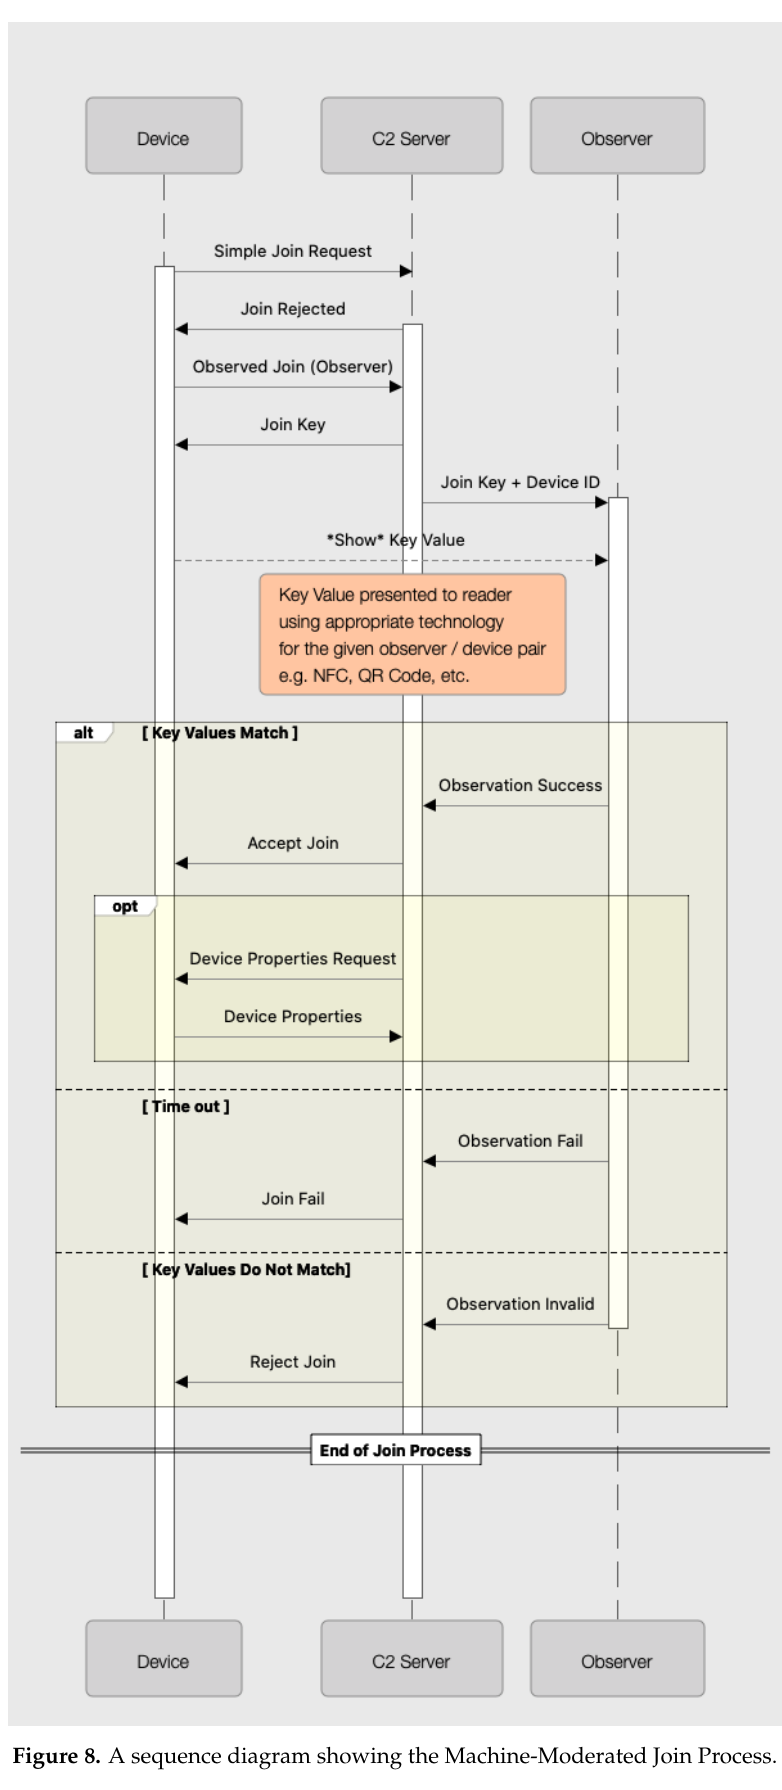
Figure 8. A sequence diagram showing the Machine-Moderated Join